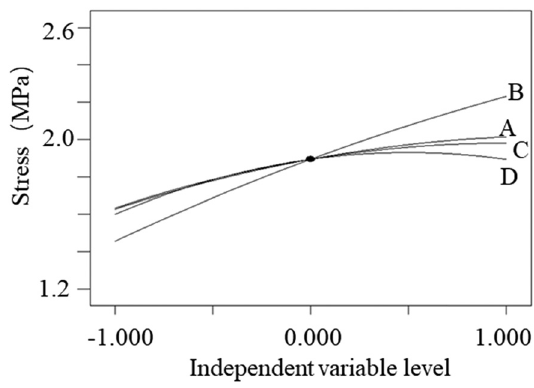
Figure 7: Single factor impact analysis diagram of σ